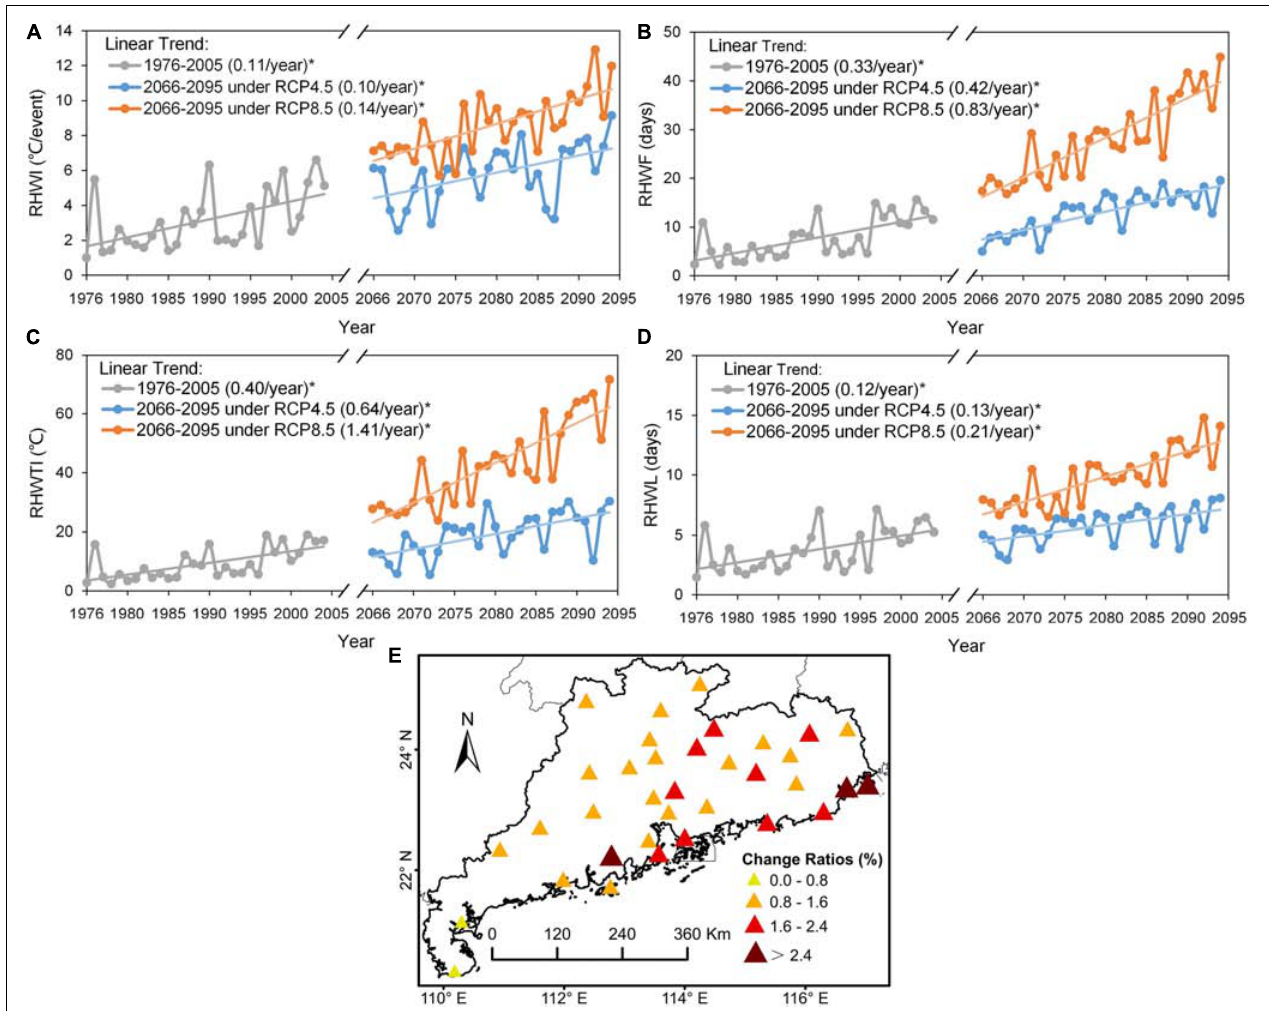
FIGURE 13 | Linear and scatter plots present the annual variations of averaged relative heat wave indicators across all of Guangdong during the historical period (1976–2005) and the future period (2066–2095) under RCP4.5 and RCP8.5 scenarios (A–D) . Panels (A–D) provided the relative heat wave indicators, consisting of intensity (i.e., RHWI), frequency (i.e., RHWF), accumulated intensity (i.e., RHWTI), and the longest duration (i.e., RHWL). Linear annual trends were estimated based on the Sen’s slope estimator, and statistical significance in trends was determined based on the MK test. The numbers in the bracket represent the estimated slope, and the asterisks denote statistically significant trends (at the 95% confidence level). The spatial distribution of the projected change ratios [(2080s under RCP8.5 minus historical)/historical] for different categories of relative heat wave intensity from the model ensemble (E) . The categories are denoted as mild (change ratio < 0.8), moderate (0.8 ≤ change ratio < 1.6), severe (1.6 ≤ change ratio < 2.4), and extreme (change ratio ≥ 2.4)